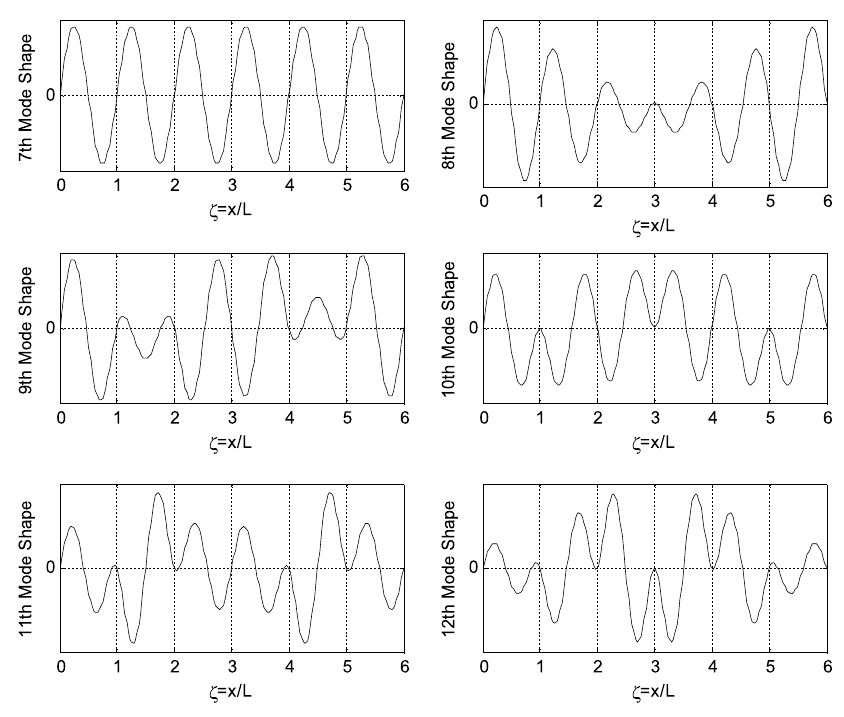
Fig. 5. Second cluster of mode shapes of the six-span